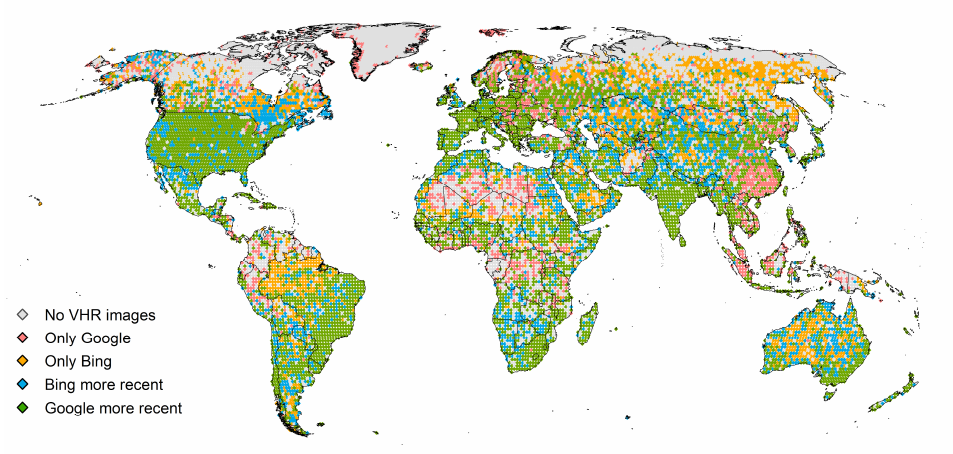
Figure 4. Comparison of the most recent VHR satellite imagery (<5 m resolution) available in Microsoft Bing Maps and Google Earth as of January 2017 (Software: Esri ® ArcMap™